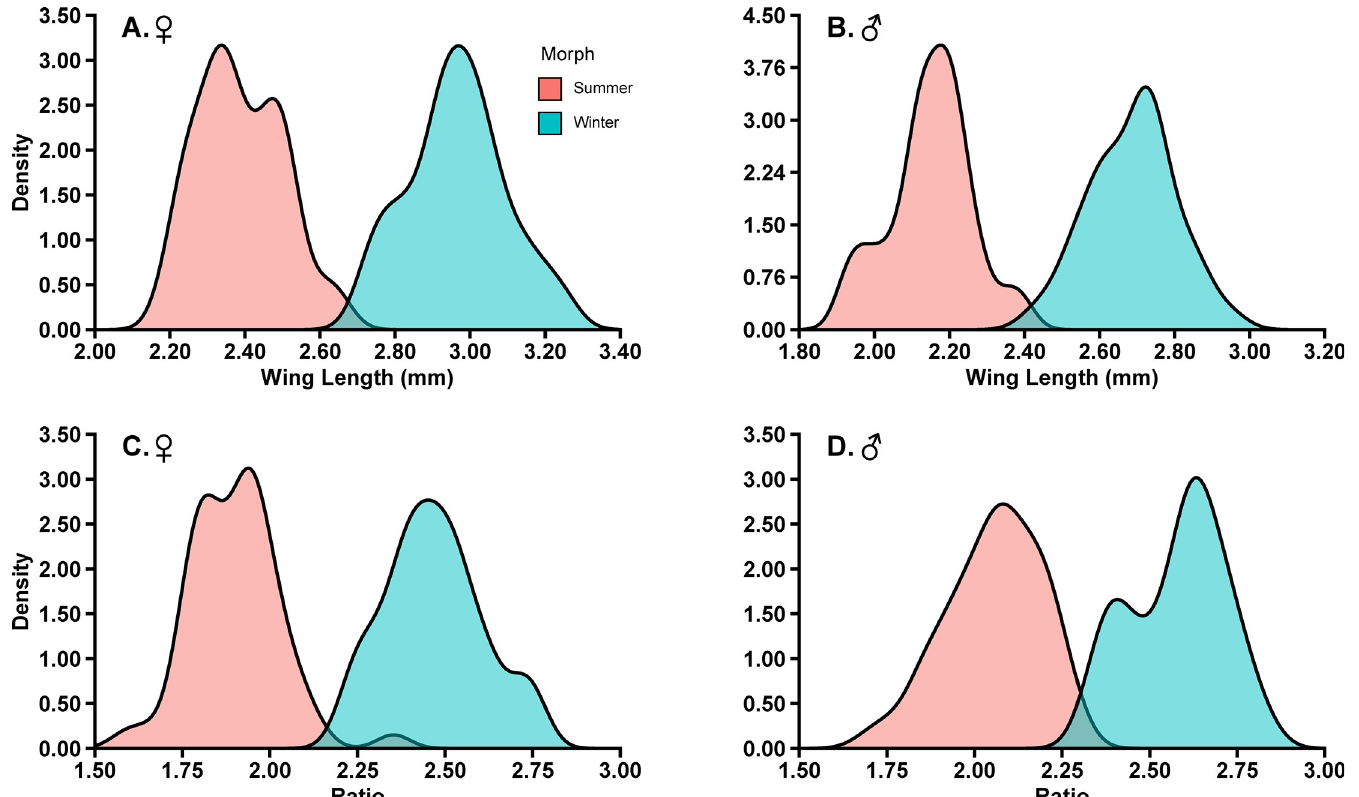
Fig 4. Density overlap for laboratory-reared D . suzukii . The percentage of density overlap based on wing length (A and B) and transformed ratio of wing length to hind tibia length (C and D) for female (A and C) and male (B and D).